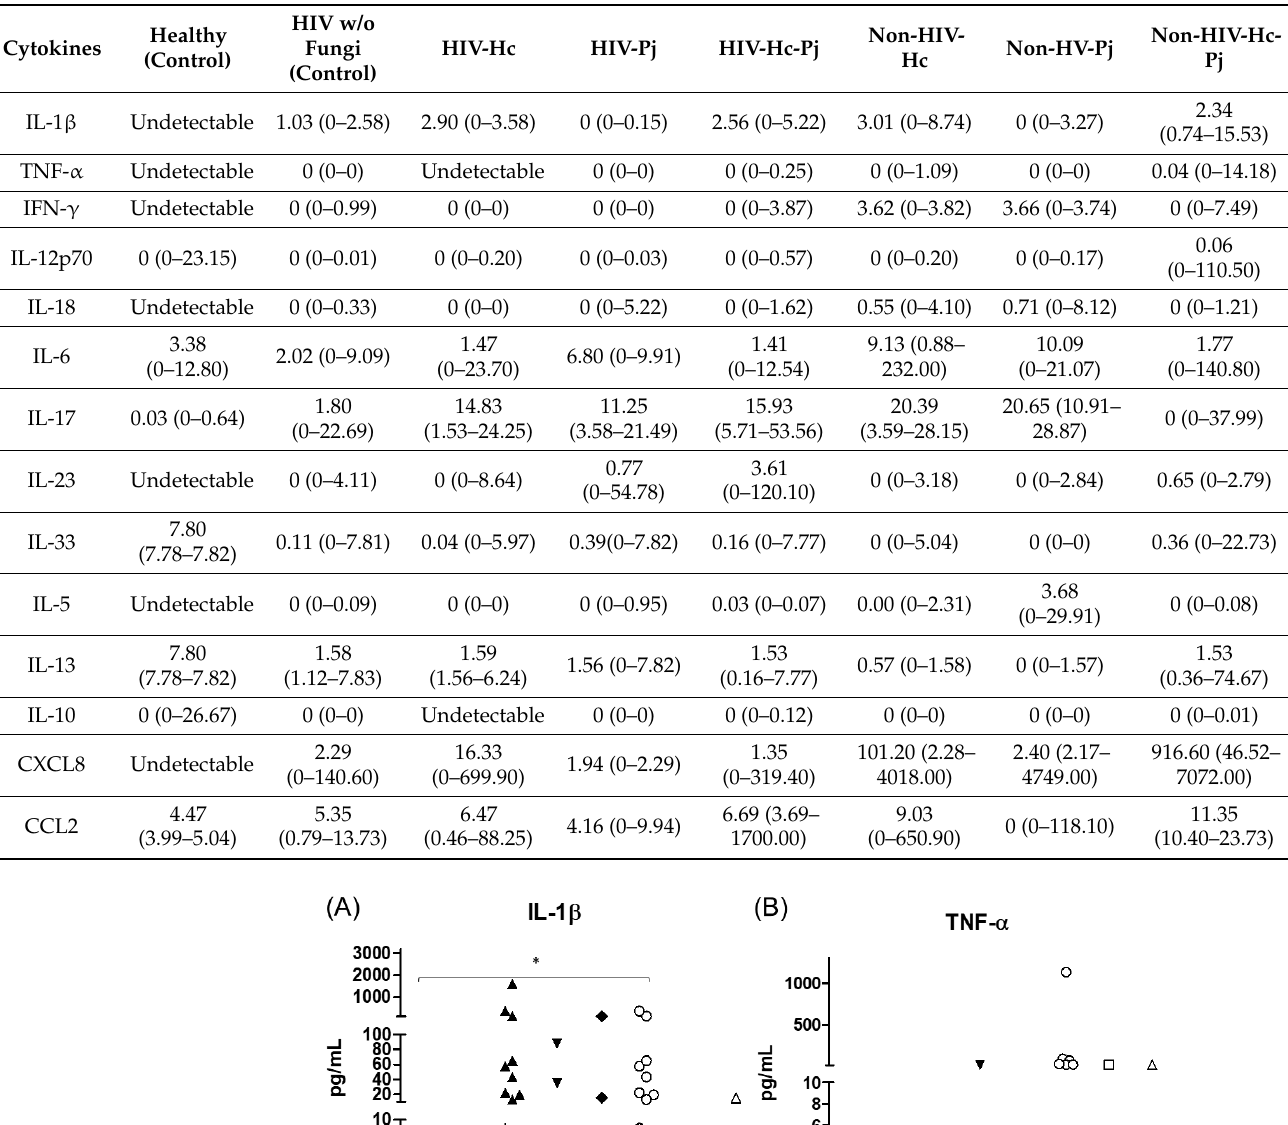
Table 3. Detection of cytokines. Median values for all group determinations are shown in pg/mL, followed by their corresponding 25–75 interquartile range in parenthesis. Abbreviations of each group of individuals are the same in all figures. The presence of cytokines was determined using the LEGENDPLEX Human Inflammation Panel (BioLegend) in BAL samples of hospitalized patients (details in the Section 2).